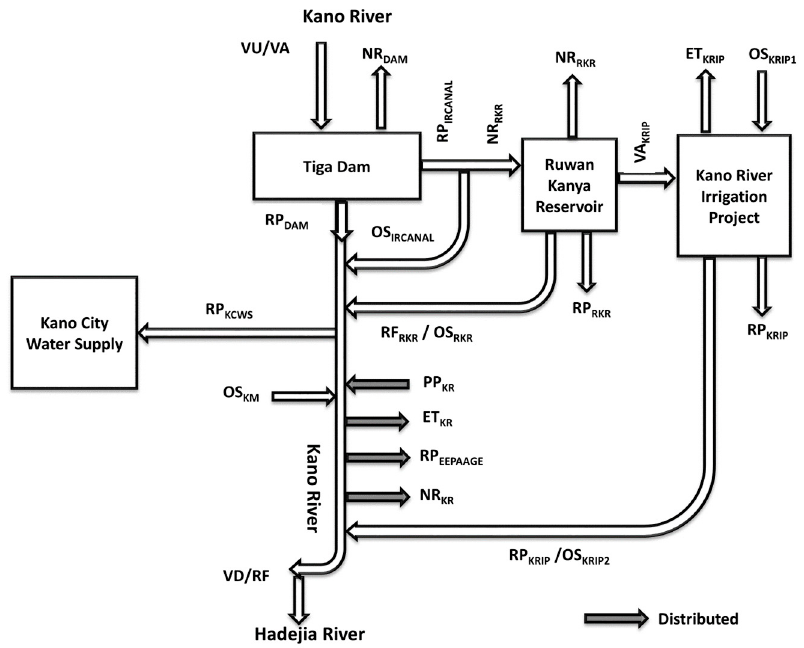
Figure 3. Typical schematic of Kano River as the WUS (M2).